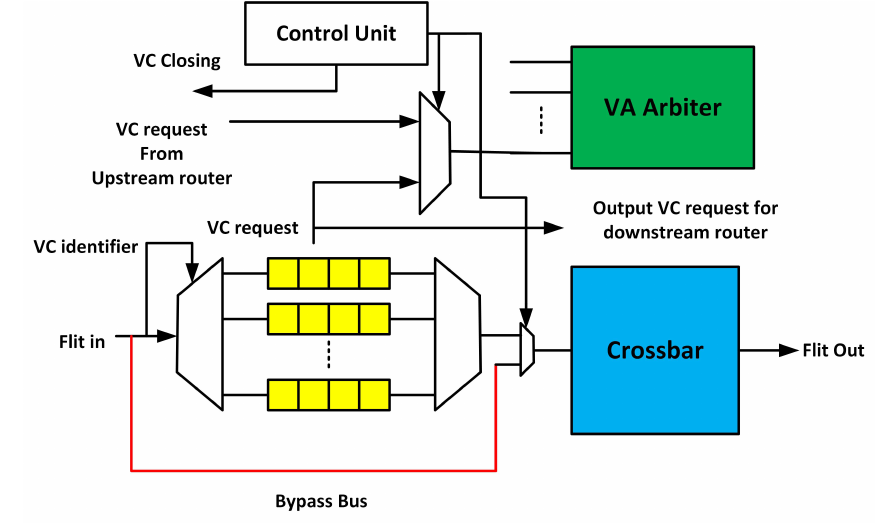
Figure 3. Input port fault-tolerant